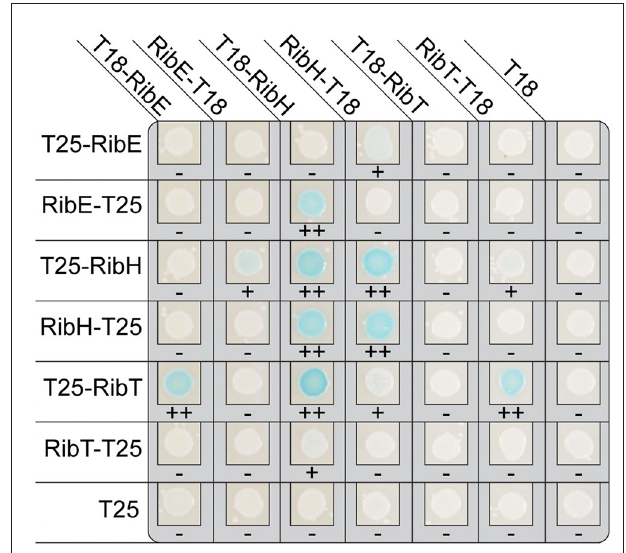
FIGURE 1 | Results of bacterial adenylate cyclase two-hybrid system (BACTH) in E. coli reporter strains using domain fusions to the Rib enzymes. The coproduced fusion enzymes are indicated on top and the respective partner fusion protein on the left. The scoring below each colony indicates the level of blue coloring, ranging from – (none), over + (light), to ++ (clearly